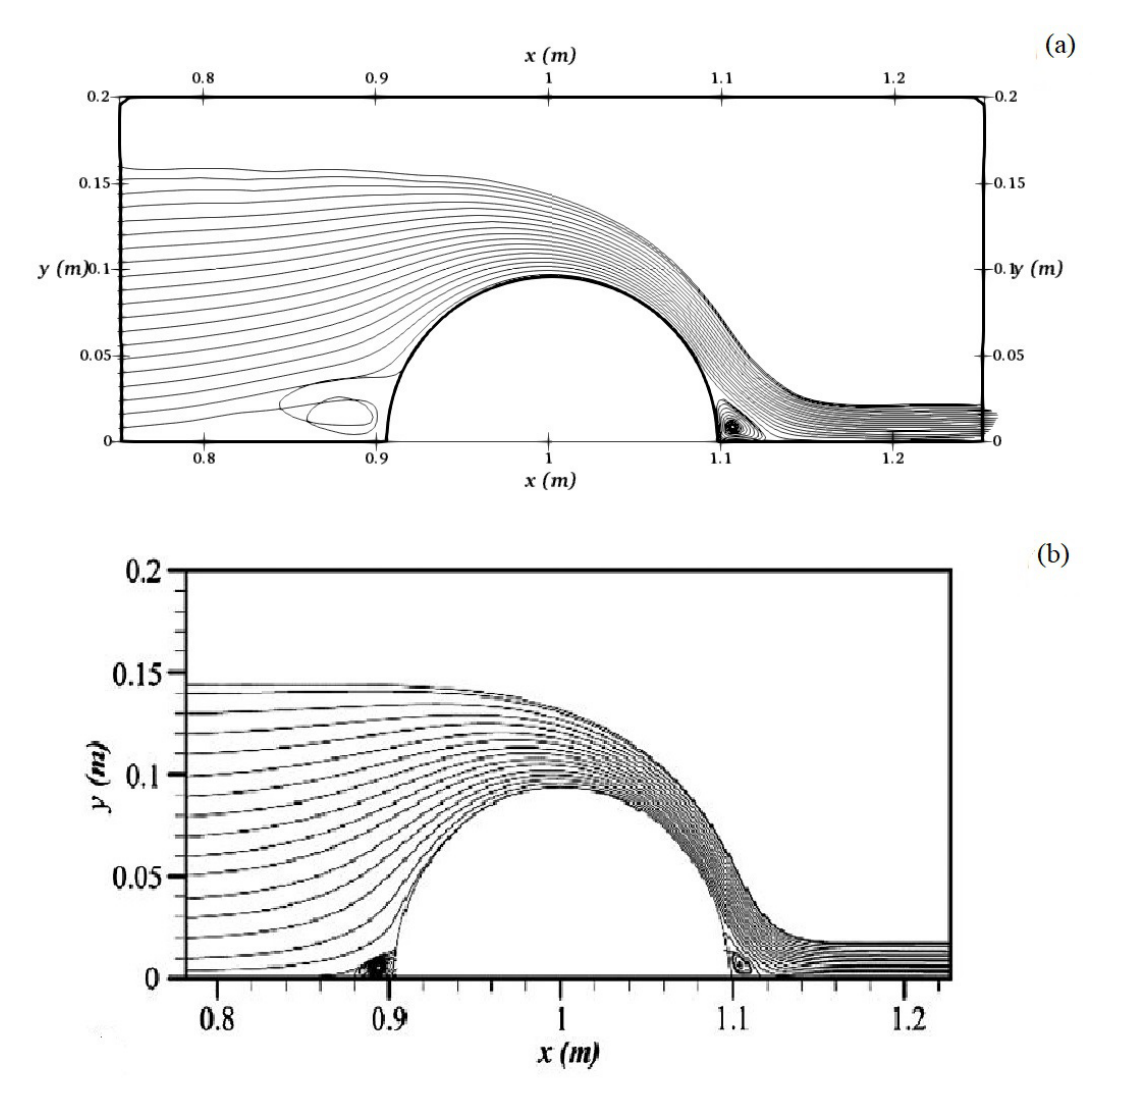
Figure 9. Comparison of streamlines in the channel over the semicylindrical dam: ( a ) obtained with caffa3d and ( b ) presented in